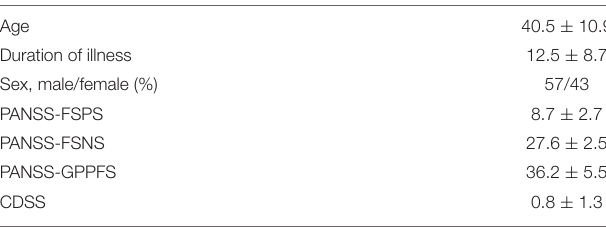
TABLE 1 | Baseline sociodemographic and clinical characteristics of the study population (mean ±